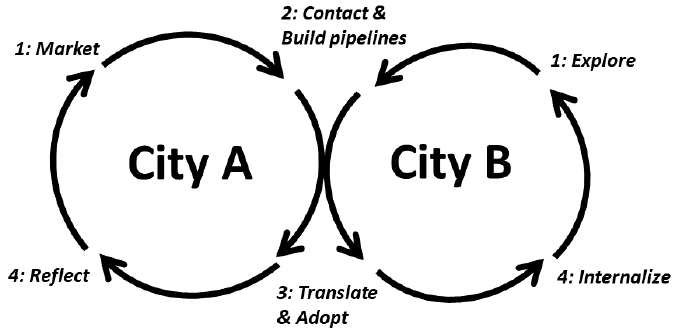
Figure 3. A circular model of the process of city-to-city knowledge transfer. City A imparts its knowledge on City B.